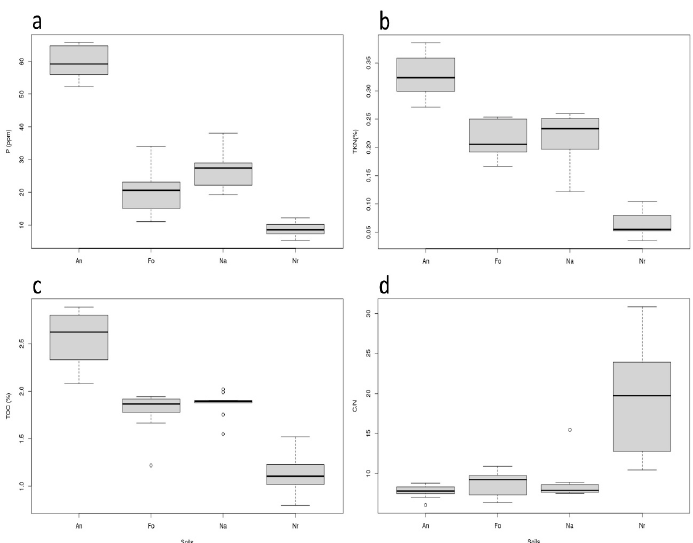
Figure 3. Variability of ( a ) available phosphorus (P), ( b ) total Kjeldahl nitrogen (TKN), ( c ) total organic carbon (TOC), and ( d ) carbon-to-nitrogen (C/N) ratios between the studied soils. The box and whisker diagrams include median value (dark rectangle), range of 50% of the samples (large rectangle), maximum and minimum values (cross bars), and outliers (circle). Table 1. Analysis of variance and Tukey’s honest significant difference (HSD) p -values of the studied variables and soil types. ANOVA p -Values Tukey’s HSD p -Values F -Value Pr (>F) An–Na An–Fo An–Nr Na–Fo Na–Nr Fo–Nr